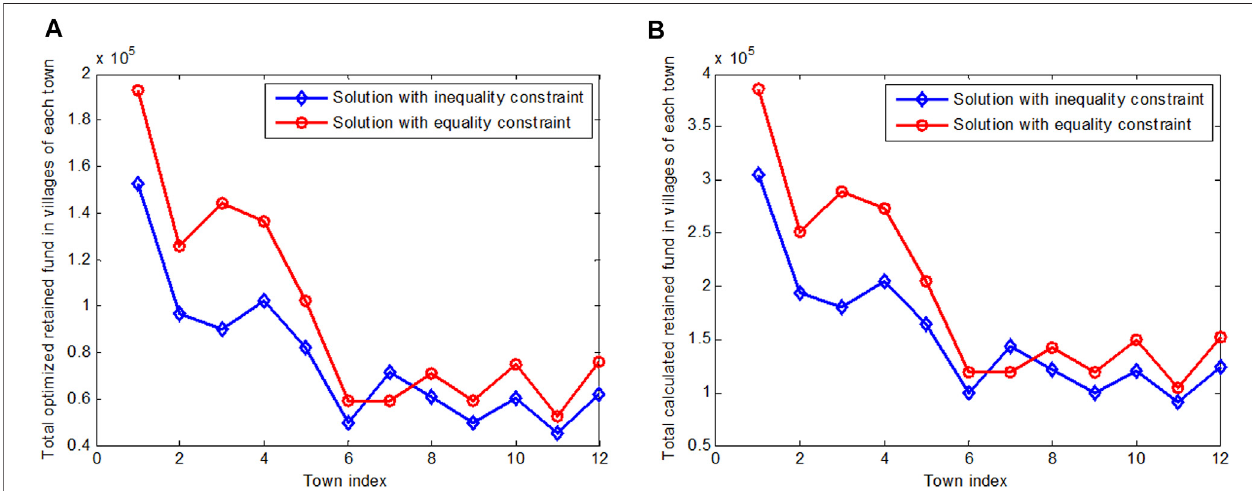
FIGURE 3 | Comparison of the retained amount at the villages of each town in the result with a larger amount of delivered garbage and an equality constraint, with that in the result with a smaller amount of delivered garbage and an inequality constraint. (A) optimized result; (B) calculated result by subtracting village cost from the